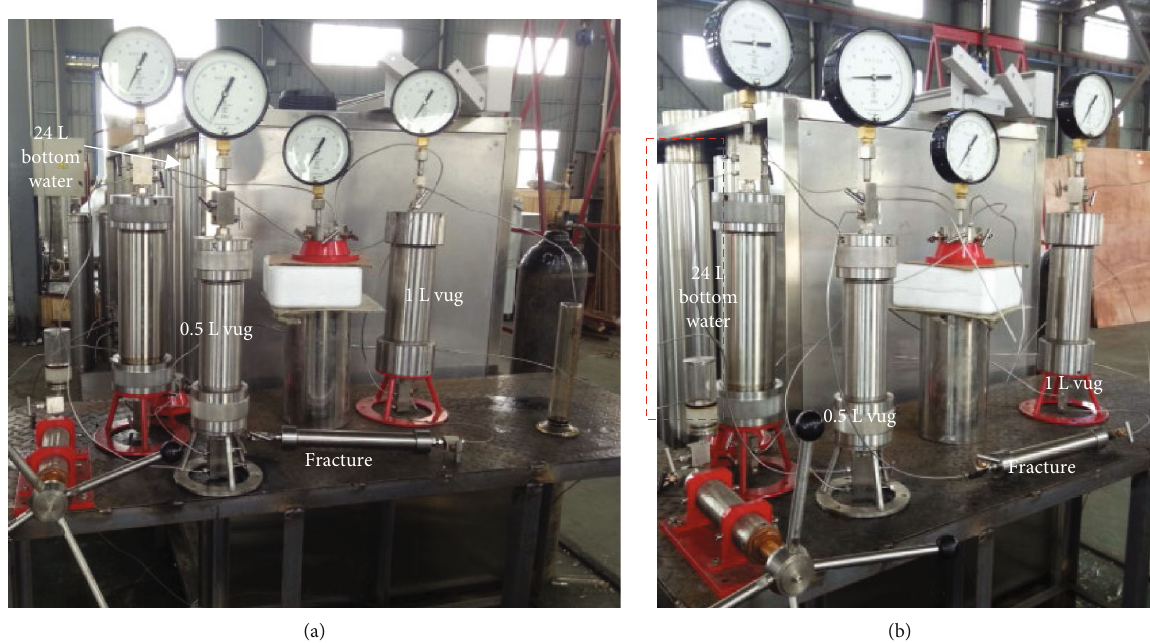
Figure 2: Pictures of high-pressure physical simulation experiment model for (a) bottom water connected to the large vug and (b) bottom water connected to the small